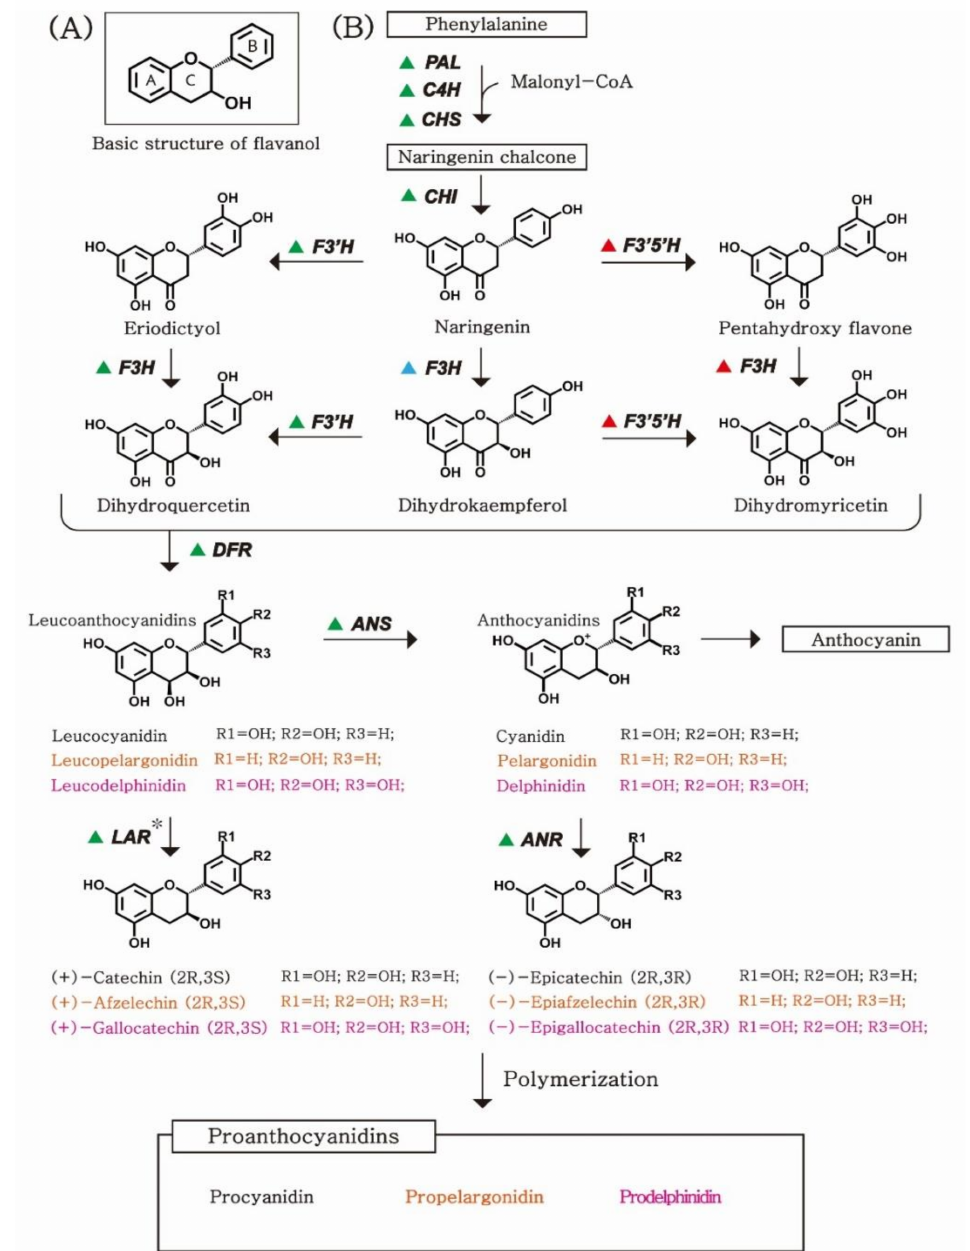
Figure 1. Biosynthetic pathway of PAs: ( A ) Basic chemical structure of flavan-3-ols. Flavan-3-ols have two benzene rings and one heterocyclic benzopyran ring. ( B ) A schematic diagram with chemical structures of flavanol compounds. Triangles indicate the species-specific enzymes involved in each biosynthetic pathway. The green triangle shows the enzymes that exist in all of our target species (Table 1); exceptionally, the LAR* gene, which catalyzes (2R, 3S)-flavanols such as catechin, was not identified in A. thaliana . A blue or red triangle indicates the enzyme that is present in grape, blueberry, and tea plant, or strawberry and almond, respectively. The names of the metabolites have been colored based on their hydroxyl pattern on the B-ring, and the black, orange, and pink designate 3 (cid:48) 4 (cid:48) -dihydroxyl, 4 (cid:48) -hydroxyl, and 4 (cid:48) 5 (cid:48) 6 (cid:48) -trihydroxyl patterns, respectively. PAs: proanthocyanidins; ANR: anthocyanidin reductase; ANS: anthocyanidin synthase; LAR: leucoanthocyanidin reductase; F3 (cid:48) H: flavonoid 3 (cid:48) -hydroxylase; F3 (cid:48) 5 (cid:48) H: flavonoid 3 (cid:48) ,5 (cid:48) -hydroxylase; DFR: